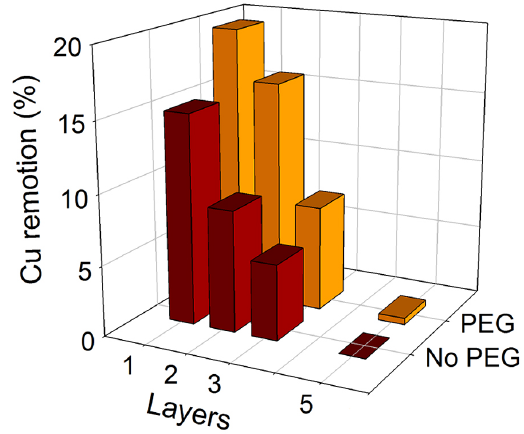
Figure 11. Copper photo‑electrolytic removal for TiO anodes versus number of deposited layers for unmodified and modified films.